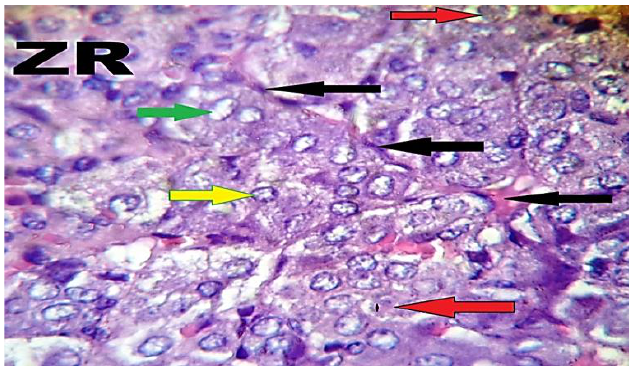
Figure 2. Hamster histological section shows medulla and zonareticularis (ZR) sinusoid (black arrow), chromaffin cell (yellow arrow) (green arrow) and postganglionic cells (red arrow). H&E,